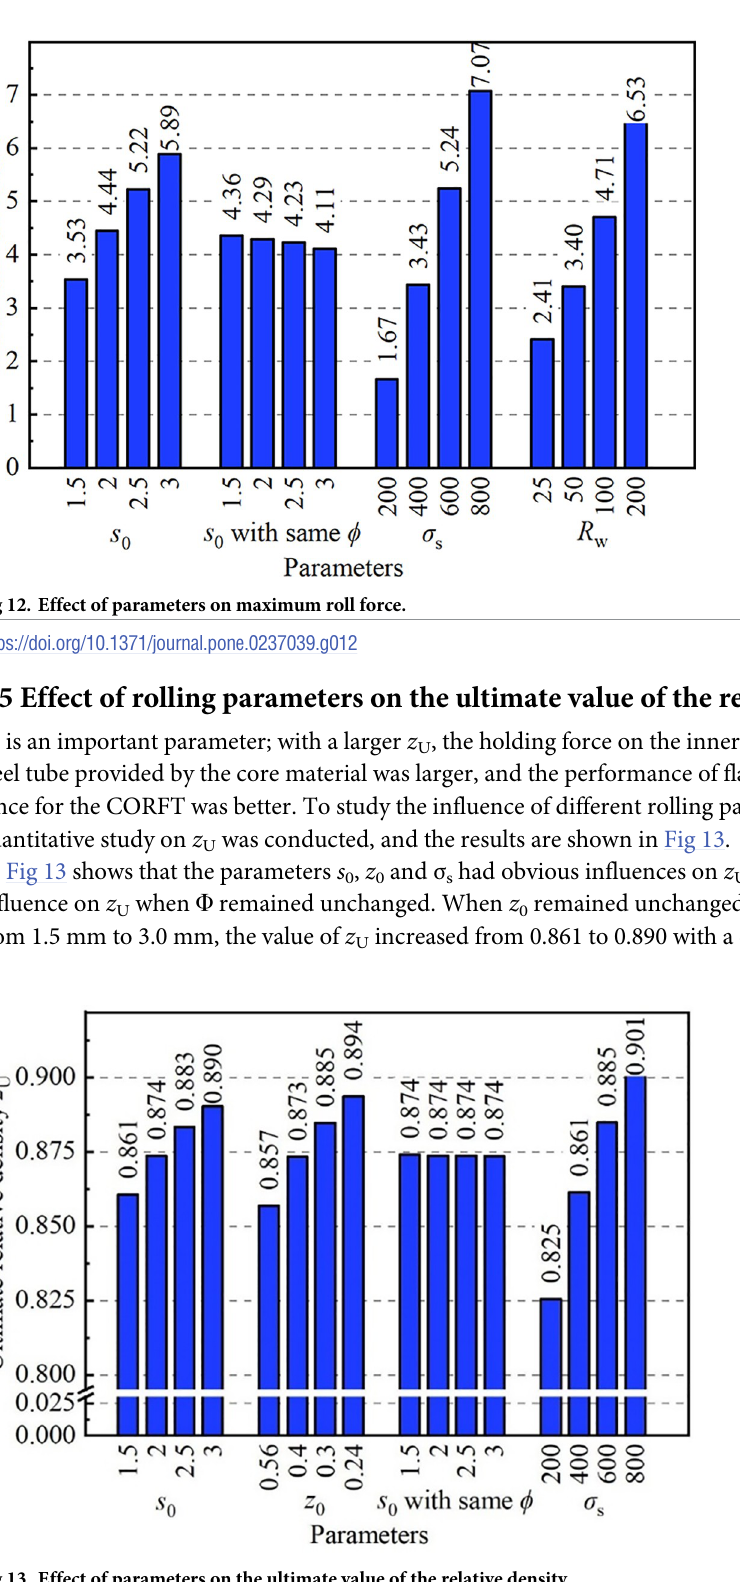
Fig 13. Effect of parameters on the ultimate value of the relative